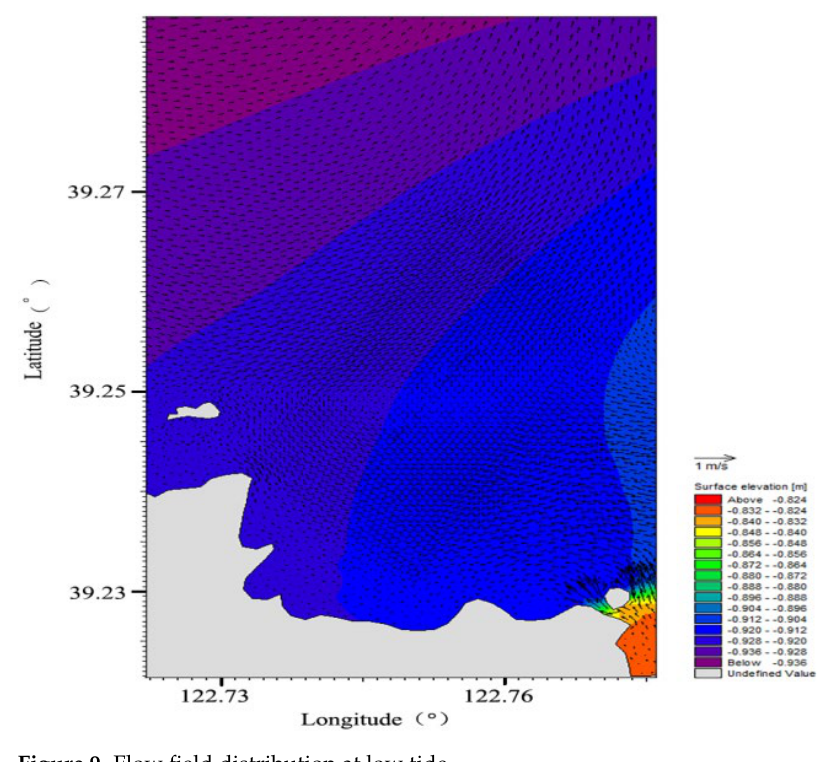
Figure 9. Flow field distribution at low tide.